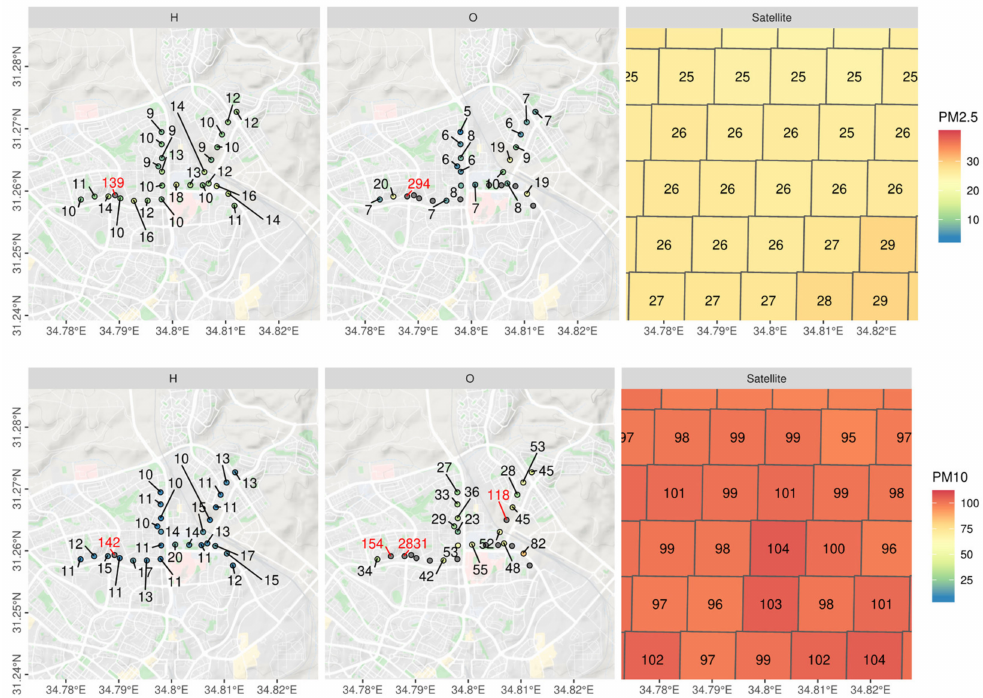
Figure 7. Mobile measurements campaign and spatial